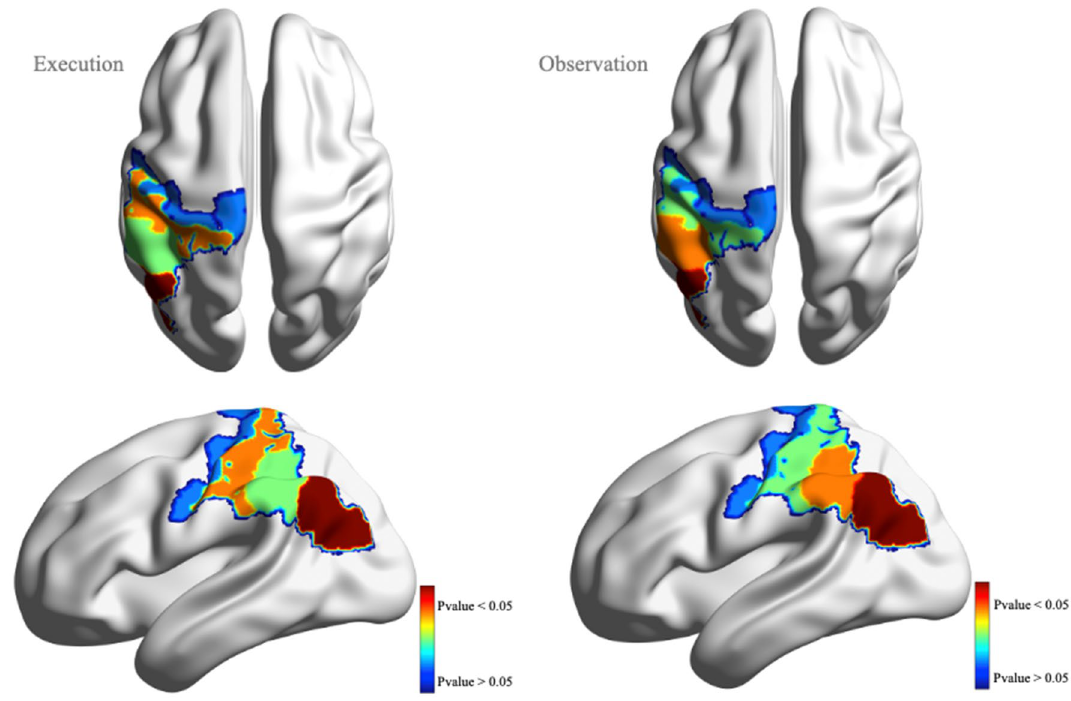
Figure 5. Extraced brain regions associated with execution (axial view on the top left, sagittal view on the bottom left) and observation (axial view on the top right, sagittal view on the bottom right). The color bar refers to the significance of the region (component). Our analysis shows the left inferior parietal lobule is the region which shows the highest covariation in fNIRS and EEG recordings (the most significant component). Interestiingly, the covariation in fNIRS and EEG signals in the right hemisphere are not shown to relate in our AON paradigm. Image generated using BrainNet Viewer software 63 .